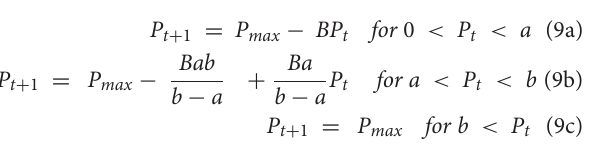
FIGURE 9 | Chaotic patterns in the basic model (K Basin/boundary collision where the lower chaotic “attractor” eventually gives way to the upper equilibrium point (b lower point is a chaotic attractor (b